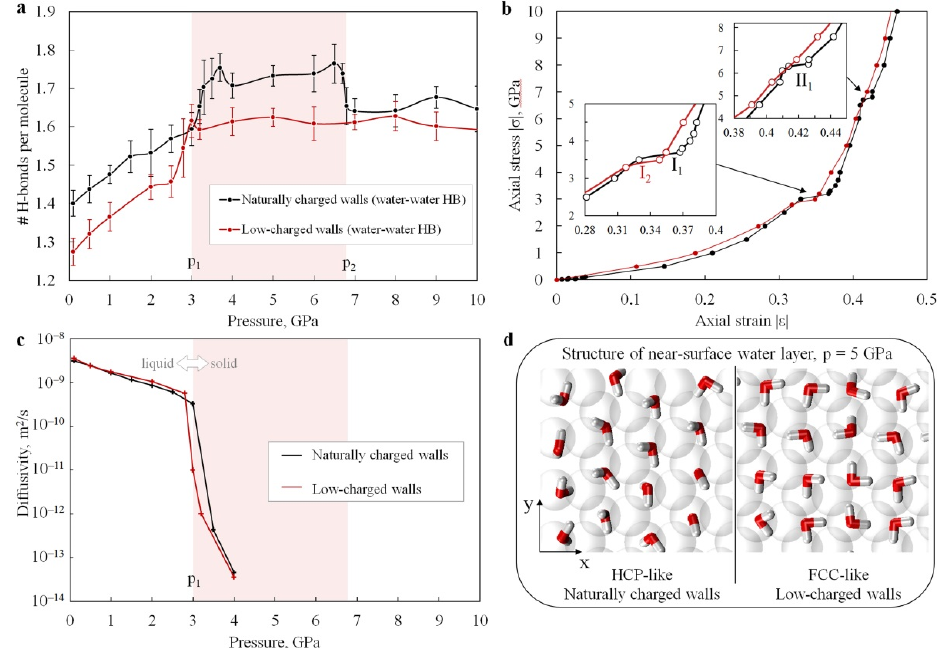
Figure 5. Physical and mechanical properties of nanoconfined water in the systems studied, obtained using the base models of 36[2Me (II) (OH) 2 ·7H 2 O]: ( a ) Average number of water–water hydrogen bonds per molecule. The red-shaded region represents the HCP-like phase in the naturally charged host model. ( b ) Estimated compression diagrams of water confined in naturally charged (black curve) and low-charged (red curve) minerals. Insets show enlarged diagram fragments for near-horizontal regions of the loading curves. ( c ) Diffusion coefficient of the nanoconfined water as a function of applied pressure, evaluated using mean square displacement (MSD). ( d ) In-plane views of the first near-surface layer of water confined in the nanopores with different wall surface polarity at p = 5 GPa. Colors: hydrogen—white, water oxygen—red, mineral oxygen—transparent spheres.